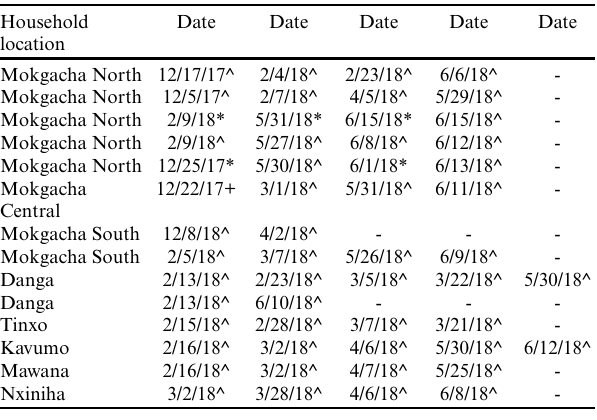
Table 2 . Firewood harvest focal follow (n = 54) schedule by